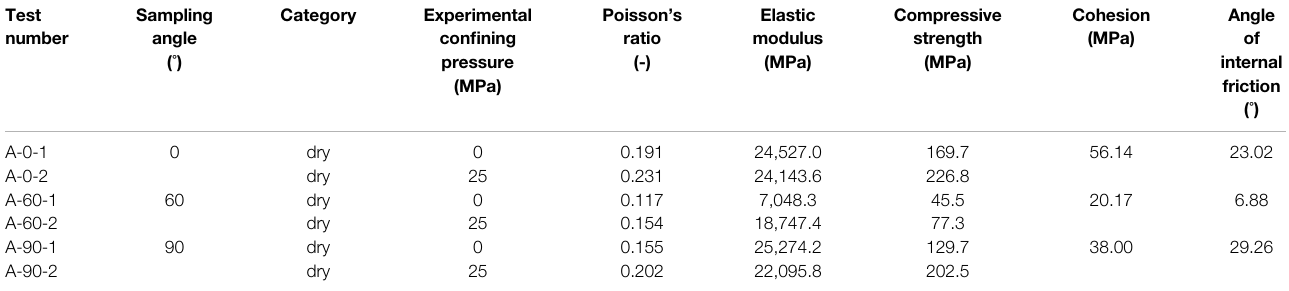
TABLE 1 | Triaxial test results of dry samples of Group A.